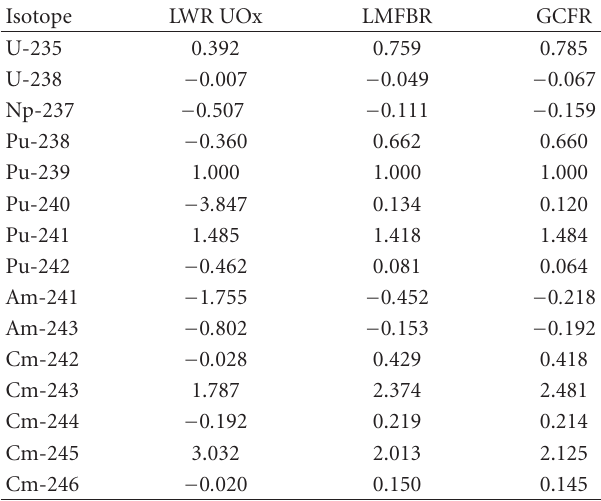
Table 1: Reactivity weights w i for several isotopes in several types of reactors, normalized to w i for Pu-239. Data sources: PWR based on EPR standard UOx fuel from [6], LMFBR based on a generic oxide fuel, sodium coolant [7], and GCFR based on GFR600 (described later in this